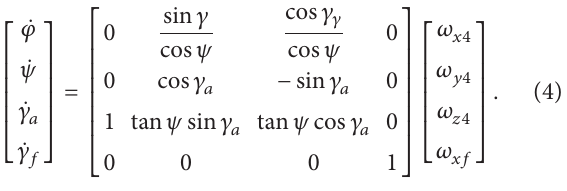
Figure 2: Coordinate transformation